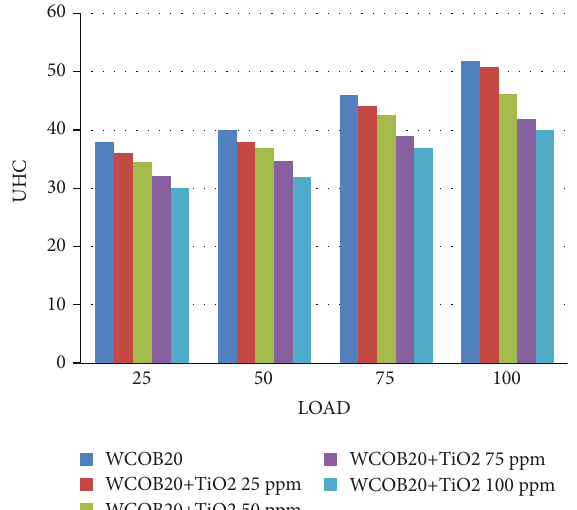
Figure 12: Variation of NO x with respect to